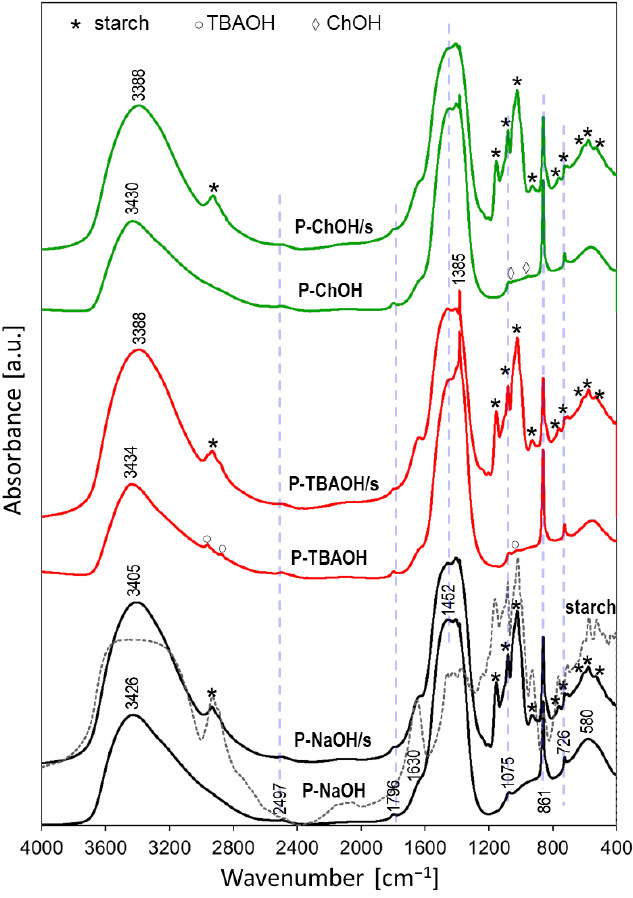
Figure 7. FTIR spectra of synthesized precursors (dried starch gel—dashed line).